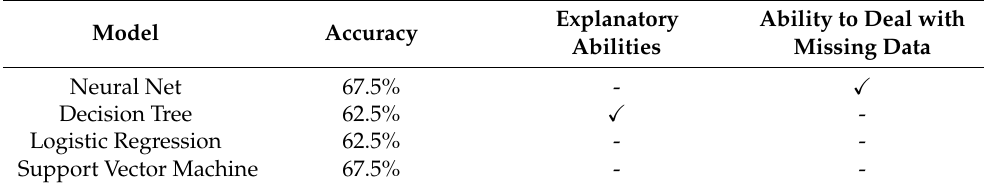
Table 6. Overview of model